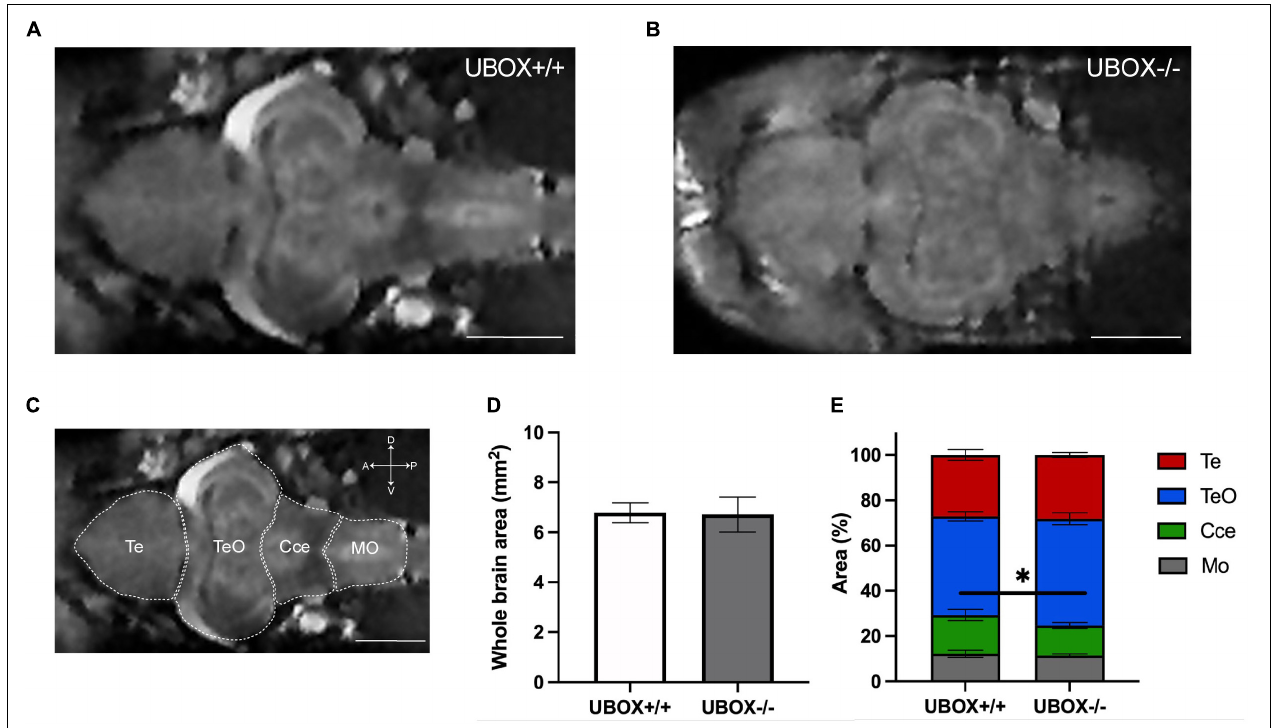
FIGURE 5 | Magnetic resonance imaging of wild-type and U-box − / − zebrafish brains demonstrate similar intact structures. MRI of the adult zebrafish brain at 24 months revealed no significant alterations in the overall brain structures between wild-type (A) and mutant (B) zebrafish. (C) Different regions of a wild-type zebrafish brain are indicated on a representative MRI image. Section area of the whole brain (D,E) the relative area of different regions (D) were calculated by using Fiji (ImageJ) software (31). Data shown are means and error bars indicate standard deviations ( ∗ p < 0.05, Student’s t -test). Scale bars in (A–C) : 1 mm. Te, telencephalon; TeO, tectum opticum; Cce, corpus cerebelli; Mo, medulla